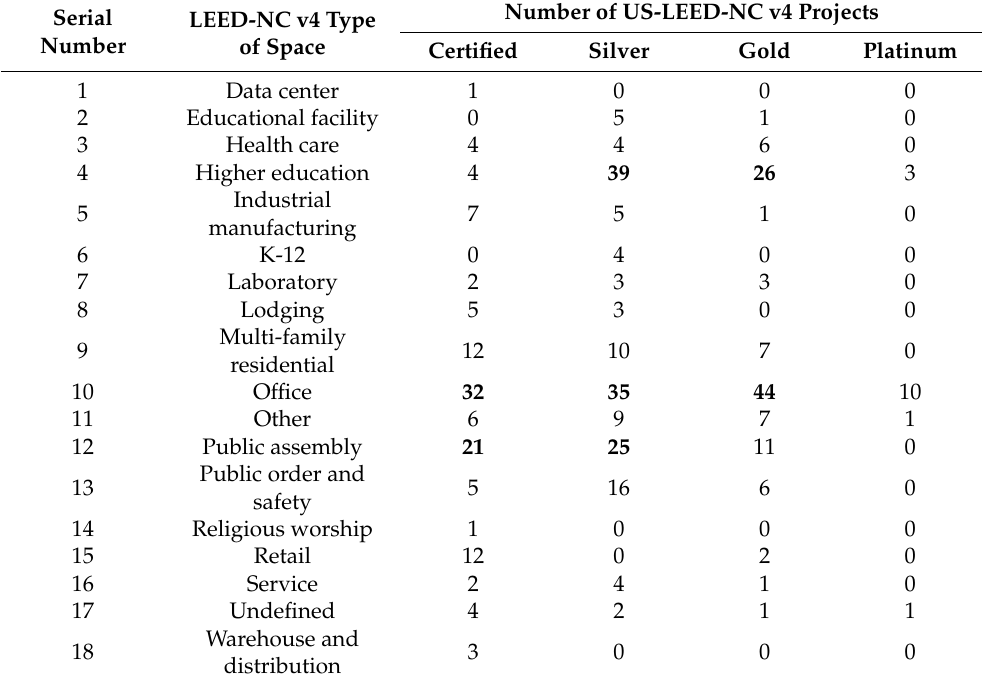
Table 1. US-LEED-NC v4 projects, in alphabetical order (accessed on 14 January